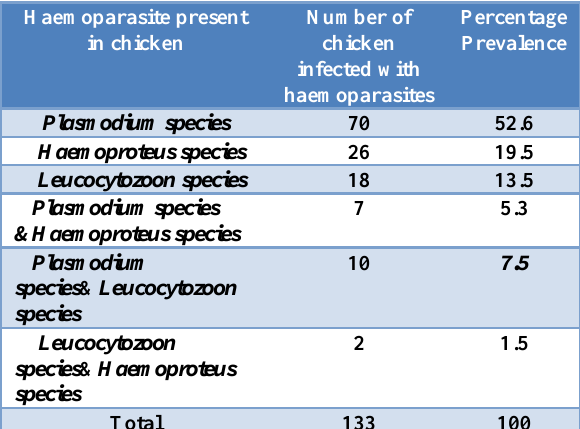
Table, 2: Prevalence of Haemoparasites in local chickens (single or mixed